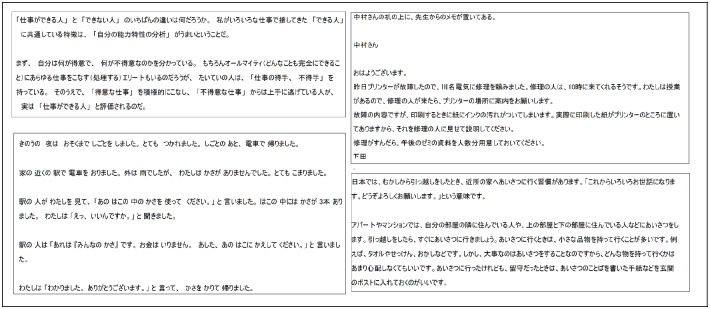
Example of JLPT texts.Level N2 (top left), level N3 (top left), level N4 (bottom right), level N5 (bottom left).